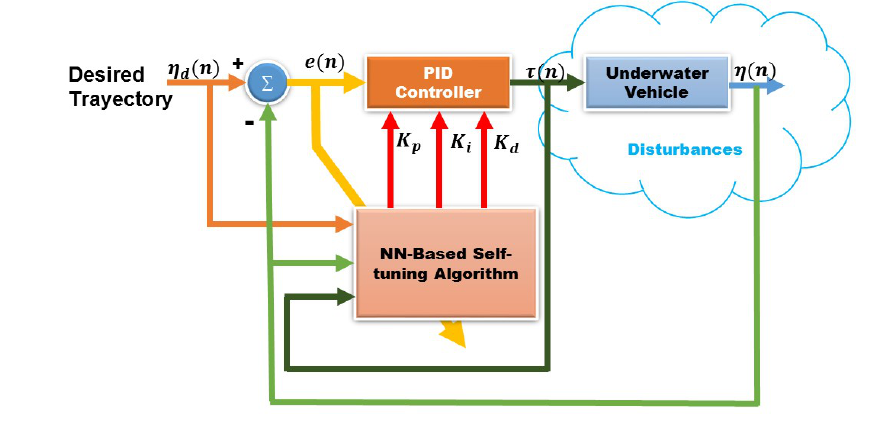
Figure 2. Block diagram of an auto-tuned PID with artificial NN control.